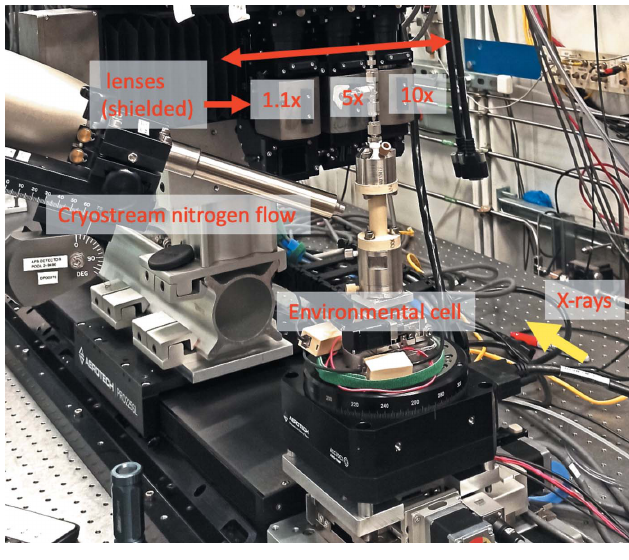
Figure 4 Setup for ice and gas hydrate formation experiments with real-time reconstruction and zooming to regions of interest.